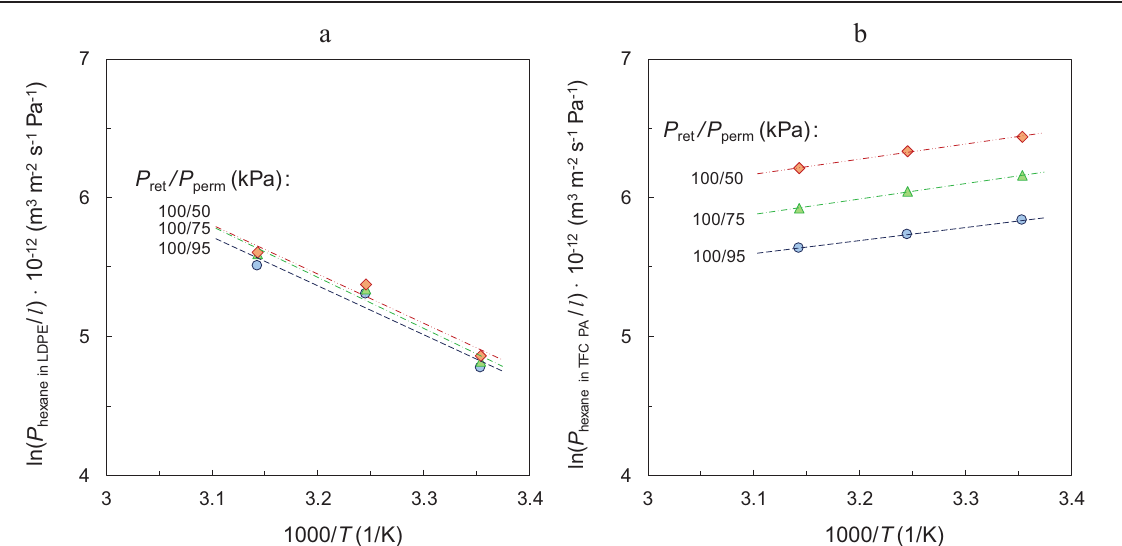
Fig. 5 – Arrhenius plots of hexane permeance at three different permeate pressures for a) LDPE and b) TFC PA membrane. The lines represent the linear least squares fit of the ln( P hex / l ) versus 1/ T according to the Arrhenius equation Eq. (6). The graphs are plotted for hexane vapour activity of 0.6.